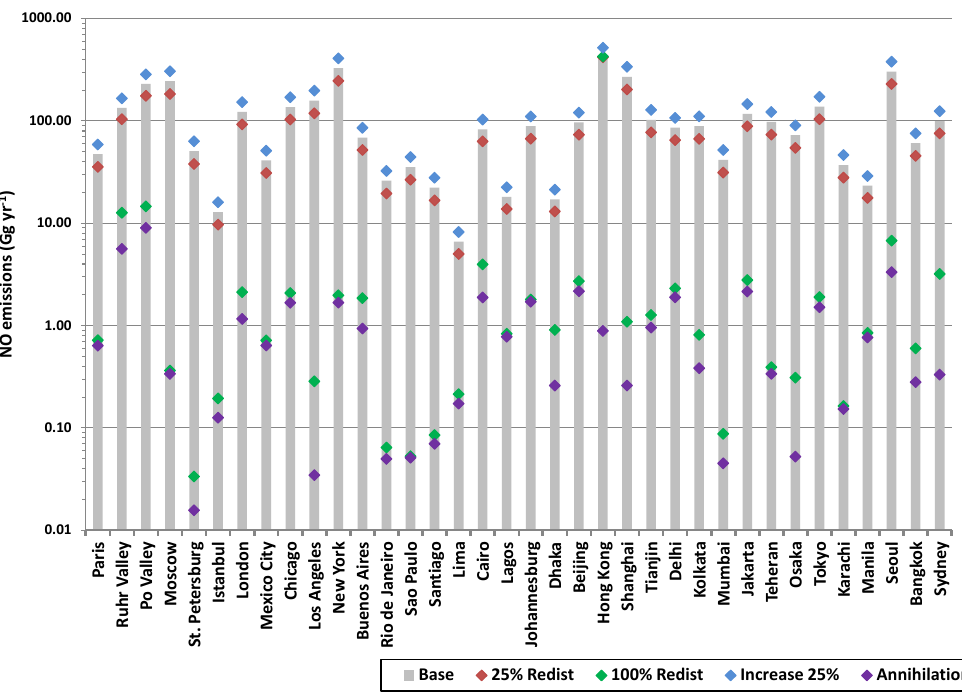
Fig. 1. NO emissions are shown in Ggyr − 1 for each of the megacities in the study under different emission scenarios. Note the scale is logarithmic to show the full range of emission perturbations. The totals are calculated on a 0.5 ◦ × 0.5 ◦